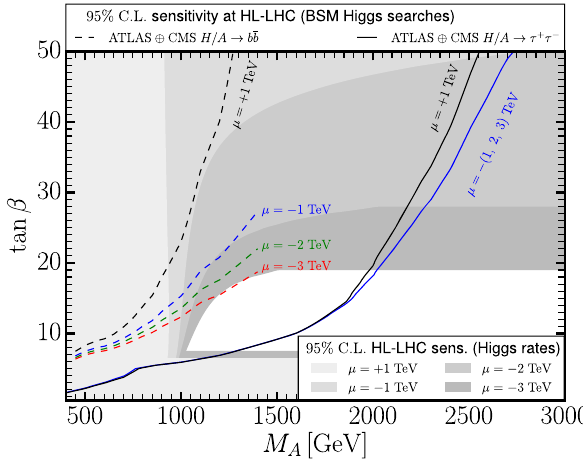
(μ = − 2TeV ) h scenario and the other choices of h , tan β ) parameter plane; the A